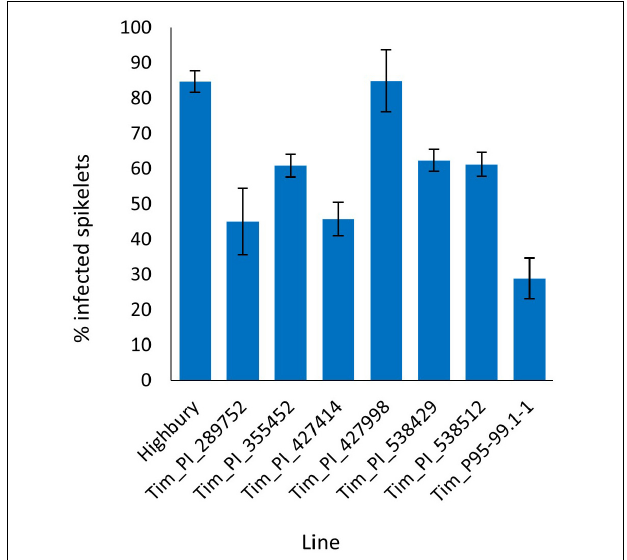
FIGURE 1 | Visual Fusarium head blight (FHB) disease score from 2015 trial of seven T. timopheevii accessions and Highbury susceptible control expressed as percentage of infected spikelets 21 days post spray inoculation with F. graminearum (1 × 10 5 conidia per